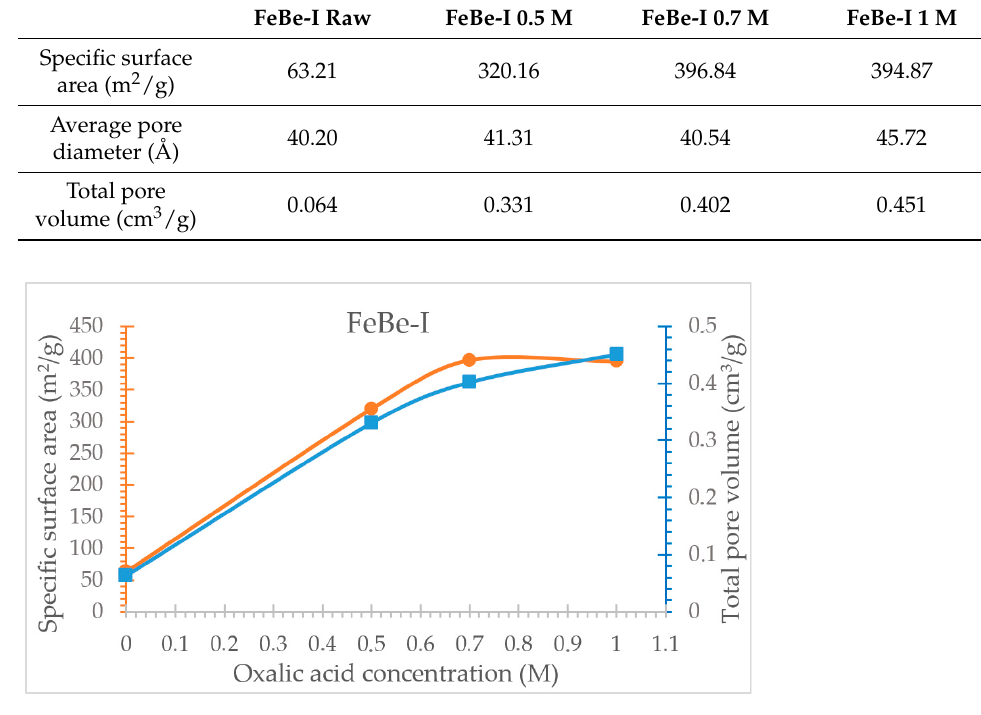
Figure 9. Pore size distribution of FeBe-I (80 °C; acid concentrations of 0.5 M, 0.7 M and 1 M; 2% of pulp density). 3.5. Bleaching Efficiency of Oxalic Acid Activated Bentonites The oxalic-acid-activated AlBe-G and FeBe-I samples were used as bleaching earths for the bleaching of soybean oil. Their bleaching efficiency was assessed by measuring the chlorophyll content and Lovibond colour of the bleached oil. The results were compared with the values of the untreated oil and those of bleached oil, using “Tonsil” as bleaching earth. The tables below present the abovementioned values (Tables 4 and 5). Table 4. Chlorophyll content of untreated and bleached oil samples (80 °C, t = 30 min, 250 rpm, 3% w / w ). Bleaching Earth